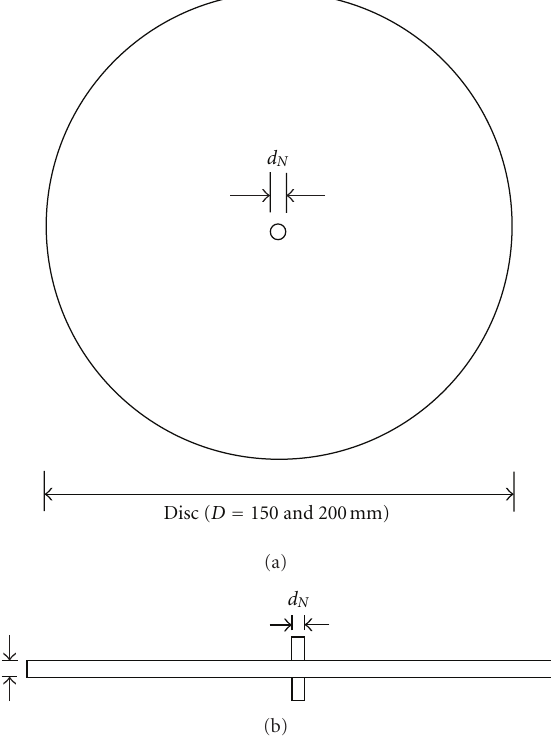
Figure 1: Geometric details. (a) Top view and (b) side